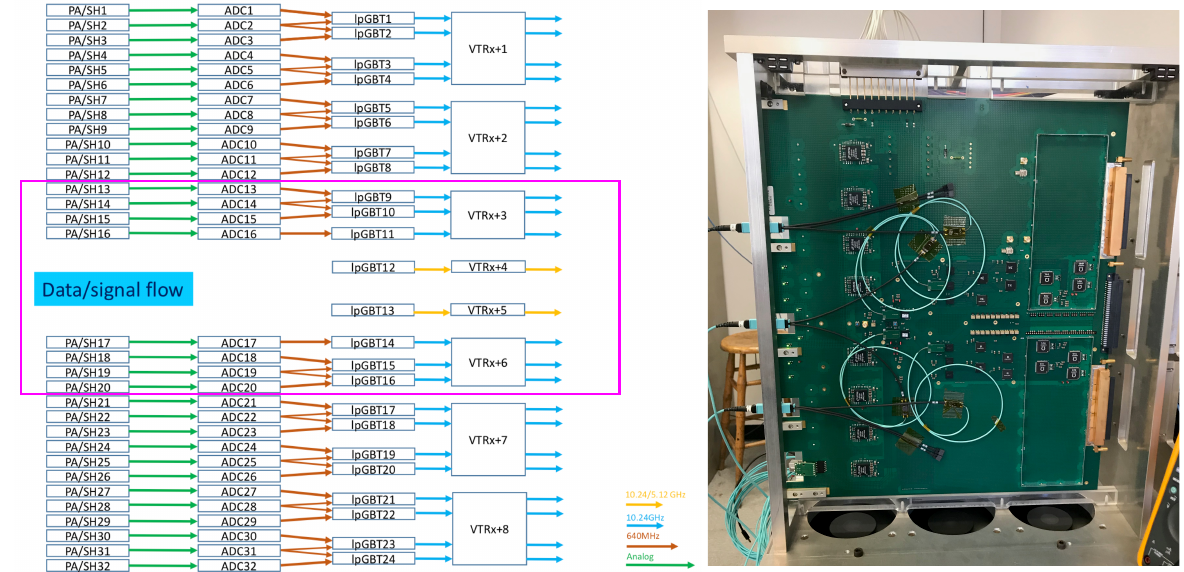
Figure 5. Data flow diagram of LAr signals on the FEB2, with the 32 channel pre-prototype slice testboard highlighted in magenta ( left ), and an image of the slice testboard ( right